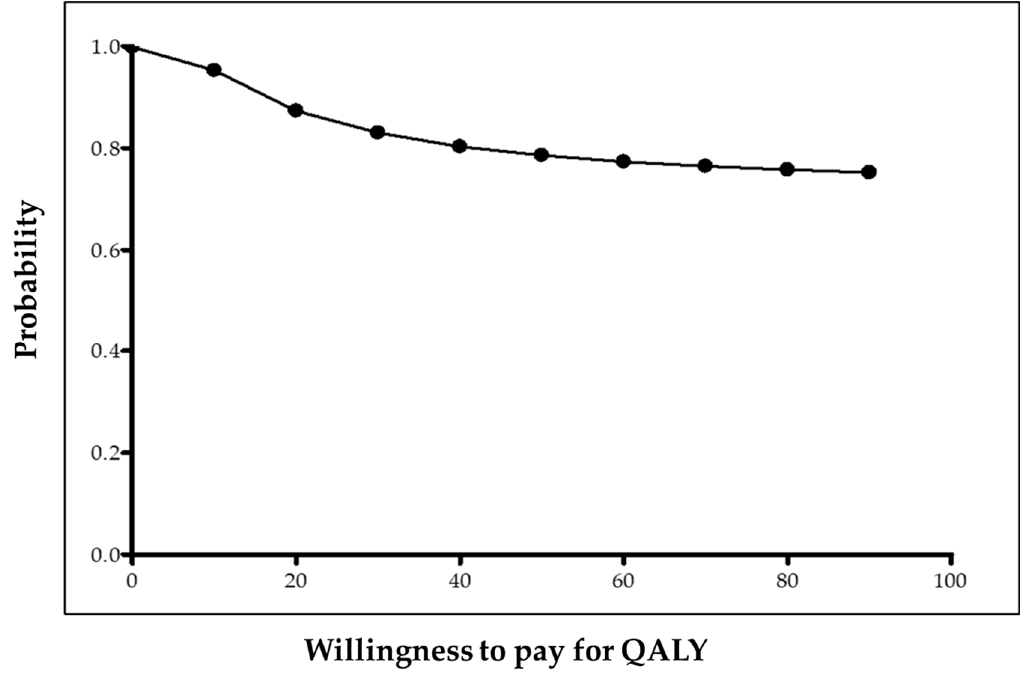
Figure 2. Cost-utility acceptability curve. The curve shows the cost–utility probabilities for PUNCH by different degrees of willingness to pay for QALYs.